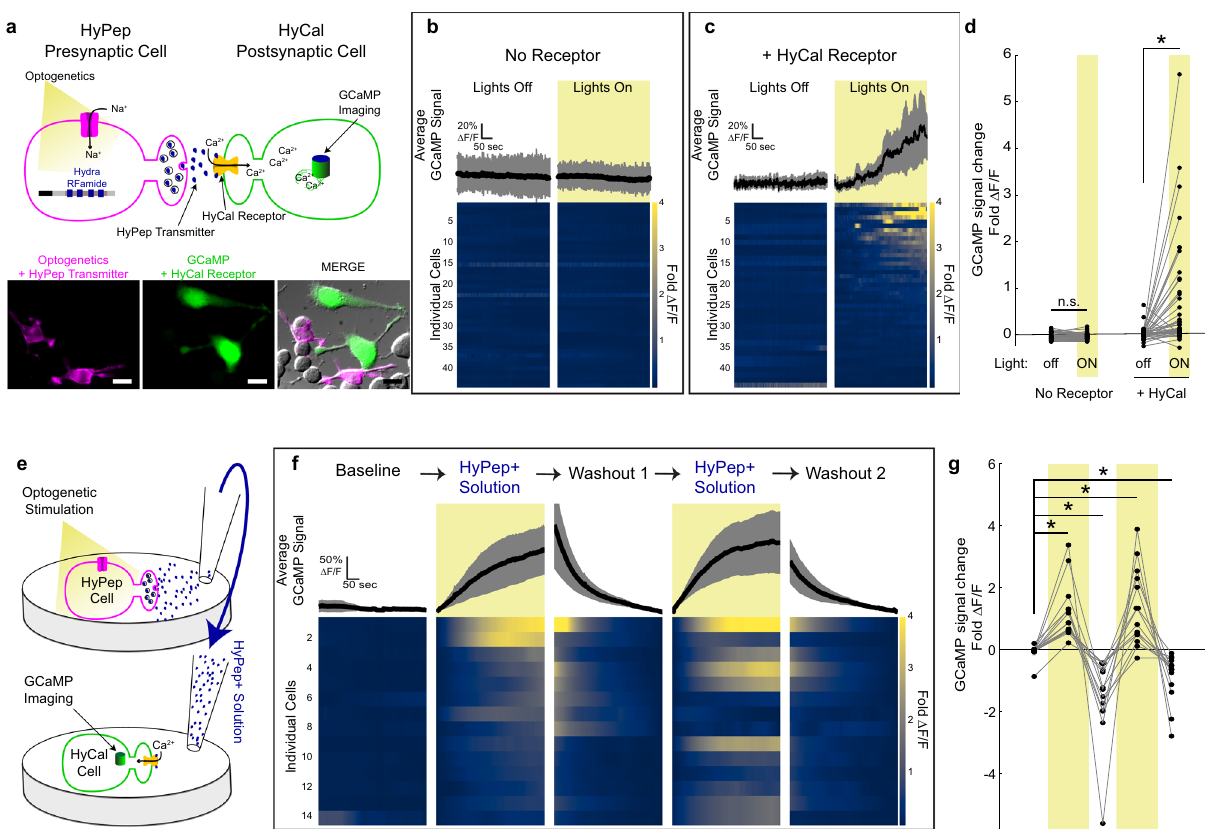
Fig. 2 HySyn produces volumetric neuromodulation of postsynaptic calcium. a Schematic illustrating the experimental paradigm used to characterize HyPep to HyCal signaling by using calcium imaging, top. Micrograph illustrating transfected Neuro2a cells used in these experiments, bottom (20 μ m scale bar). Chrimson was used for optogenetic stimulation (591 nm, 500 ms at 1 Hz) of “ presynaptic ” cells expressing the HyPep carrier of the neuropeptide ( “ Hydra RFamide ” ). GCaMP was expressed in distinct cells either alone ( b ) or with the cognate receptor HyCal ( c ), and both of these two groups of cells were co-cultivated with HyPep “ presynaptic ” cells. b Average GCaMP signals, top bold line with shaded 95% con fi dence intervals, and individual cell heatmap pro fi les, bottom, for Neuro2a cells expressing GCaMP alone. Without receptor expression, but even in the presence of HyPep-secreting cells co- expressing the optogenetic tool (Chrimson), GCaMP signals remained stable in these cells both without (left, “ Lights Off ” ) and with (right, “ Lights On ” , yellow shading) optogenetic stimulation of the HyPep cells. c As in b , but in cells also expressing the HyCal receptor in the presence of HyPep-secreting cells co-expressing the optogenetic tool (Chrimson). We observe calcium signal rise over the course of light stimulation. Out of 44 cells, ~34% (14) showed changes in fl uorescence over 3 standard deviations beyond the mean change observed prior to light stimulation. d Quanti fi cation of the change in GCaMP signal (mean Δ F / F in fi nal 30 s minus mean Δ F / F in fi rst 30 s) revealed that optogenetic stimulation of co-cultured HyPep-expressing cells co- expressing the optogenetic tool (Chrimson) did not result in stimulation of potential “ postsynaptic ” cells lacking the HyCal receptor (but expressing GCaMP). In contrast, they resulted in a doubling of intracellular calcium signal in cells expressing the HyCal receptor ( p = 1.0 for “ No Receptor ” ( n = 43) Lights off vs ON, p = 0.00002 for “ + HyCal Receptor ” ( n = 44) Lights off vs ON). e Schematic illustration of solution transfer experiments. After optogenetic stimulation (as in a for 5 min), the bathing solution from HyPep-expressing cells ( “ HyPep + Solution ” ) was transferred to naive “ postsynaptic ” cells in another culture dish expressing GCaMP and the HyCal receptor. f Following a stable baseline, applying the HyPep + solution increased the GCaMP signal, and this rise was reversed after washout and applying the fresh bathing solution (Washout). Repeated cycles of washout and application of the HyPep + solution reproducibly increased the GCaMP signal in the same responding cells ( n = 14, p = 0.00004 1st addition, p = 0.0001 Washout 1, p = 0.0003 2nd addition, p = 0.0003 Washout 2). g To highlight the kinetics of individual responding cells (from panel f ), we quanti fi ed (as in d ) GCaMP changes for cells that displayed responses. Error bars (and shaded regions in b , c , f ) indicate 95% con fi dence intervals and * indicates p < 0.05 using two- tailed Mann – Whitney – Wilcoxon test with Bonferroni correction for multiple comparisons. Transfection and reporter expression (micrographs in a ) were reproducibly observed, including in the 22 cases where successful electrophysiological recordings were made (Supplementary Fig. 2), and in 3 independent populations with GCaMP expression (Fig. 2). Source data are provided as a Source Data fi